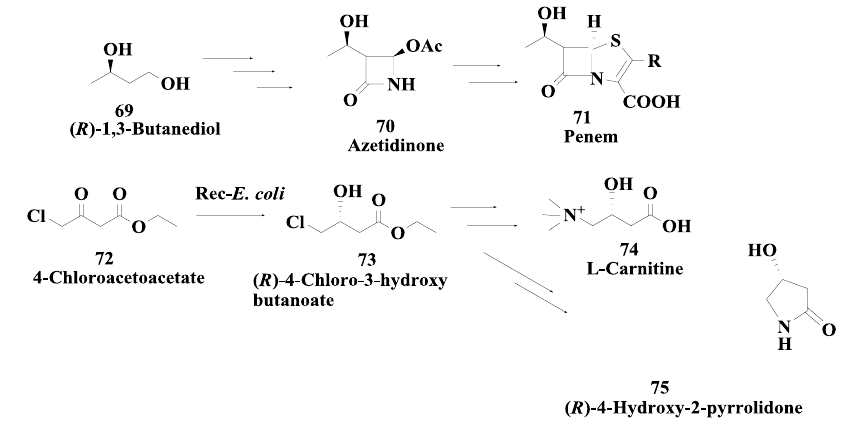
Figure 18. Penem and carbapenem: Enzymatic preparation of ( R )-1,3-butanediol and ( R